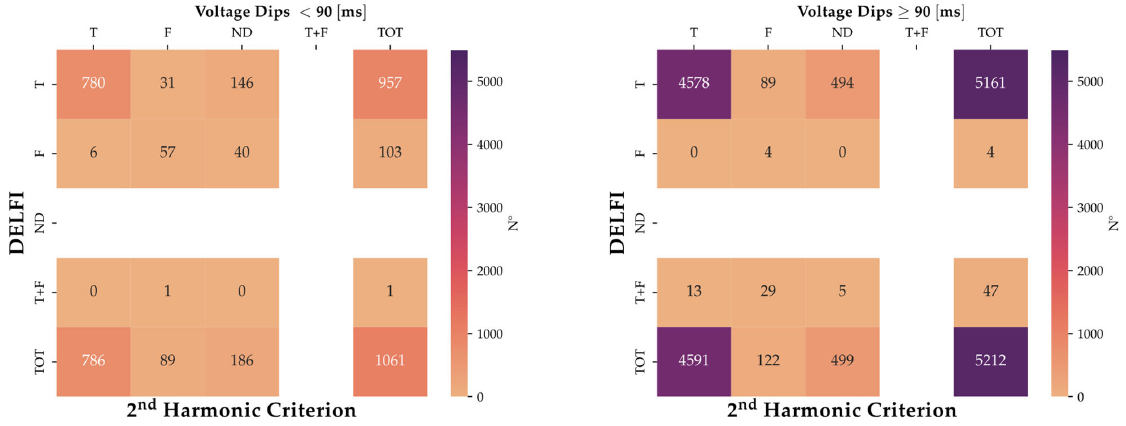
Figure 16. Validity assessment: 2nd Harmonic and DELFI outcomes with respect to voltage durations for CN Subset.